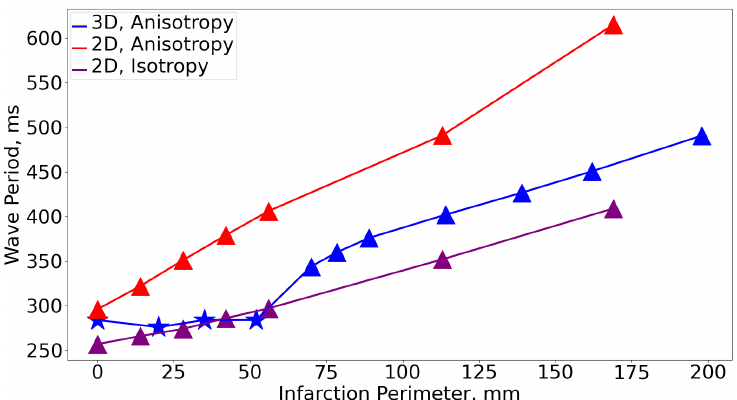
Figure 9. Comparison of dependencies of the wave period on the perimeter of the infarction scar in 3D anatomical model (blue line) and 2D tissue simulations (isotropic case, purple line; anisotropic case, red line). The width of the gray zone for all models is 7.5 mm. A star indicates functional rotation and a triangle indicates gray zone rotation